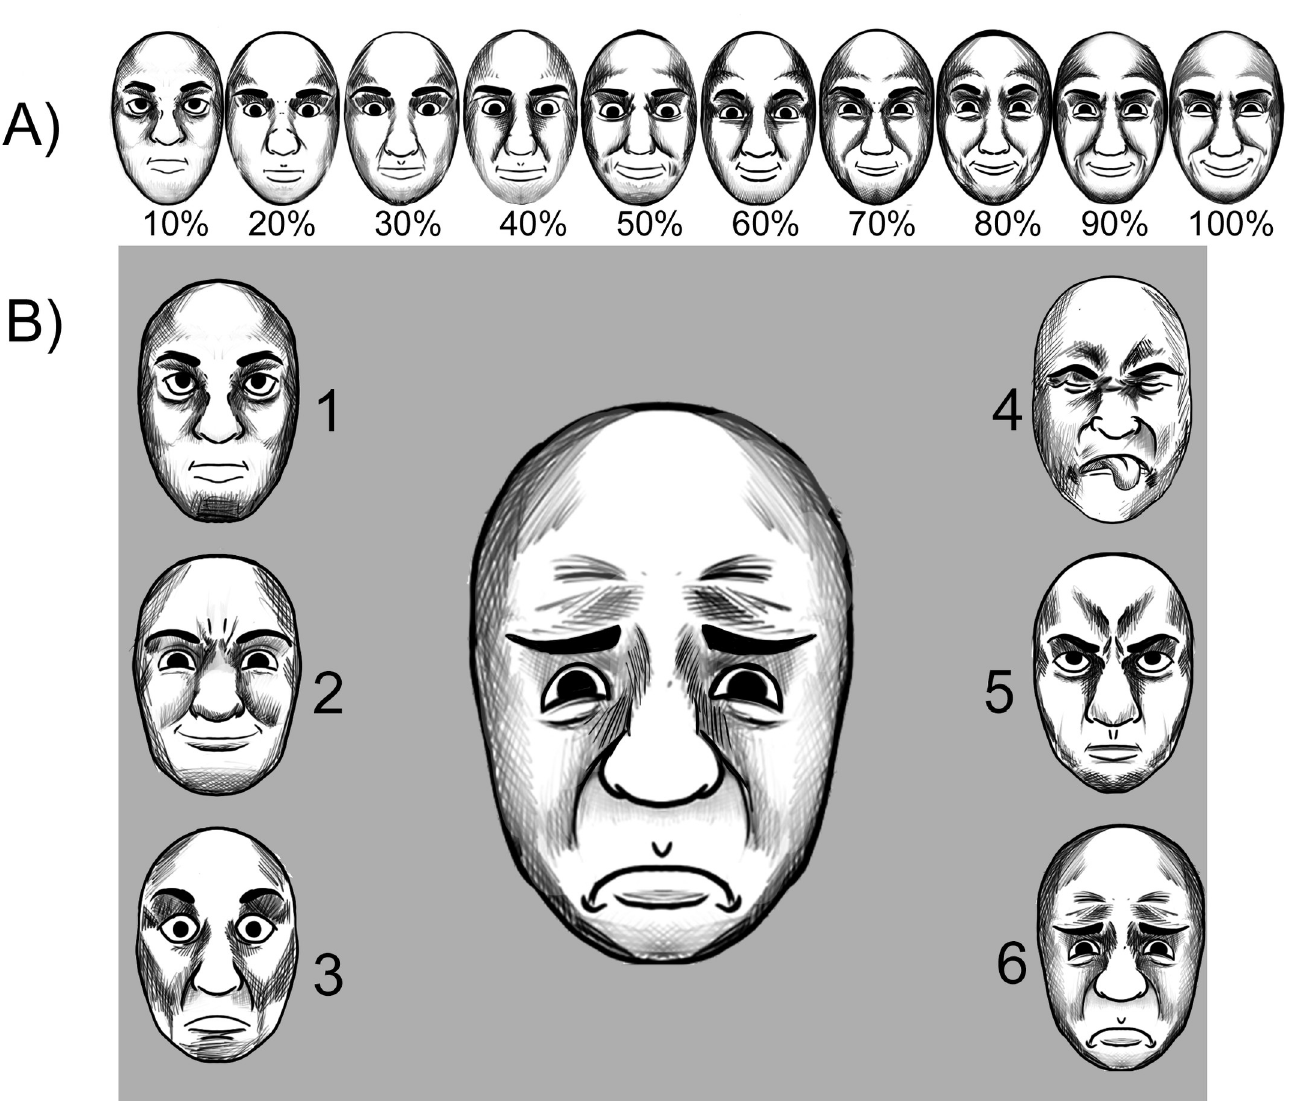
Fig 1. Visual stimuli examples. (A) Illustrative example of the linear continuum of morphs created by morphing the neutral expression with the happiness face. (B) Illustrative example of the facial identification task. The large expression in the center is a sadness expression. These images do not correspond to the actual stimuli used in the experiment, and were created just for the purpose of illustrating the facial morphing procedure and the facial identification task in this article. The images used in the experiment (obtained from The NimStim set of facial expressions) are protected by copyrights and not freely available to be